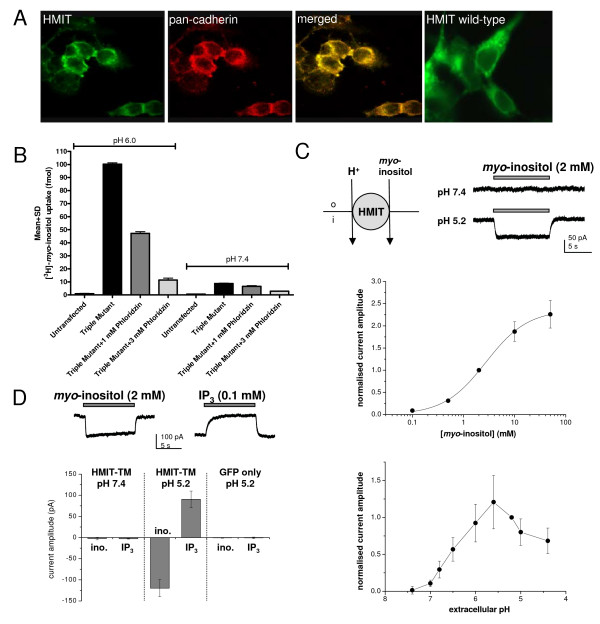
HMIT activity in HEK293T cells transiently expressing HMIT triple mutant at the plasma membrane. A HMIT triple mutant is expressed at the plasma membrane in HEK cells as indicated by co-localisation with pan-cadherin antibody (Abcam, 1:1000) observed by confocal microscopy, in contrast to wild-type HMIT, which is mainly localised intracellularly. B [3H]-myo-inositol uptake and its concentration dependent inhibition using the non-selective HMIT inhibitor phloridzin were demonstrated at pH 6.0. C Top left: schematic diagram illustrating the proposed electrogenic transport by HMIT. Top right: representative traces of inositol-evoked currents recorded in a HEK293T cell transiently transfected with HMIT triple mutant (HMIT-TM). Middle: concentration-response relationship for myo-inositol in the HMIT triple mutant at pH 5.2 (n = 5–9 cells per data point). Bottom: pH sensitivity of currents evoked by myo-inositol (2 mM), recordings were made in HEK293T cells transfected with the HMIT triple mutant (n = 4–7 per data point). D The HMIT triple mutant was also demonstrated to transport IP3. Similar to observations with myo-inositol, the electrogenic transport of IP3 was observed at pH 5.2 and not at pH 7.4 (n = 4–6 per data point).